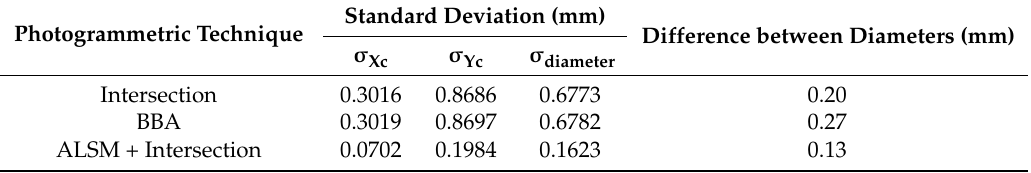
Figure 11. Circle fitting in the textured areas: ( a ) above the strip and ( b ) below the strip. Table 5 presents the standard deviations and errors that result from the circle fitting in the two textured areas extracted from the cylinder, which were called Part I and Part II. The errors were computed by comparing the estimated diameters with the value that was measured directly with a calliper. When only the SIFT keypoints were used, the diameter error was 0.003 mm in Part I and 0.0079 mm in Part II. The largest standard deviations indicated in the centre circle determination a dispersion of approximately 0.37 mm in X and 2 mm in Y, with 1.74 mm for the diameter. However, more accurate values were obtained with the ALSM technique, which generates errors of 0.0001 mm and 0.0033 m for Parts I and II, respectively. In addition, the standard deviations were also smaller and in both Parts I and II were below 0.20 mm. The results with the textured area were more accurate than those achieved with the checkered strip because in those patches, the gradients are concentrated in a few directions, and the internal areas are homogenous and did not contribute to improving the